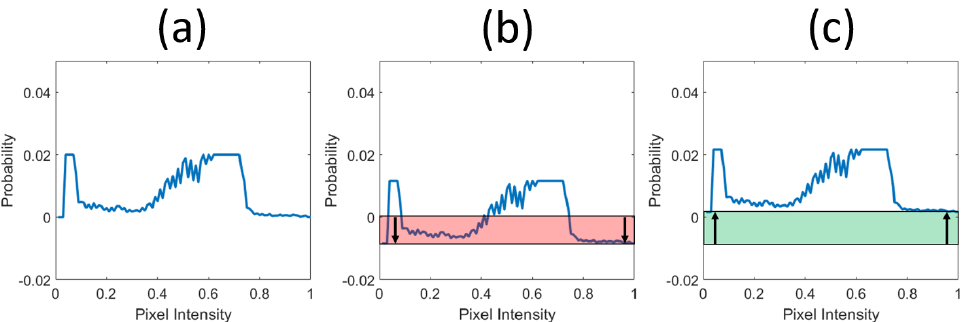
Figure 5. Manipulating a histogram (with N bins) until it sums to 1. ( a ) A histogram. ( b ) Histogram with all bins evenly decremented until it sums to 0. ( c ) All bins incremented by 1 now sums to